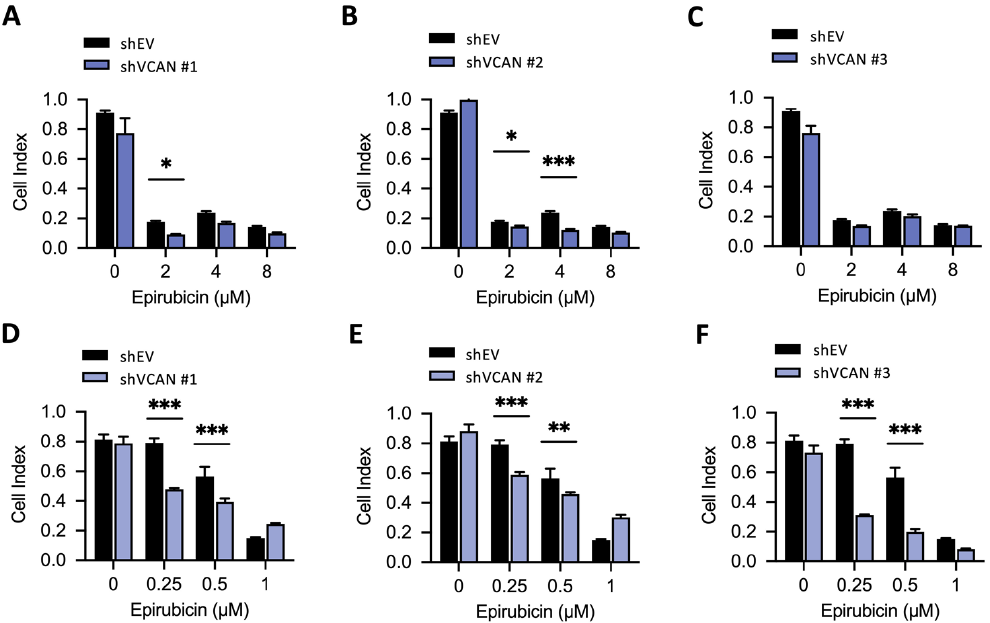
Figure 8. Silencing of VCAN enhanced the efficacy of low-dose epirubicin in UTUC. ( A – F ) BFTC909- shEV, shVCAN#1, shVCAN#2 and shVCAN#3 cells were treated with different concentrations of the drugs for 3 days, and the cell viability was then determined using the WST-1 assay. The data are presented as mean ± SD, and statistical analysis was performed using a two-way ANOVA with Sidak’s multiple comparisons test. * p < 0.05; ** p < 0.01; *** p < 0.001.